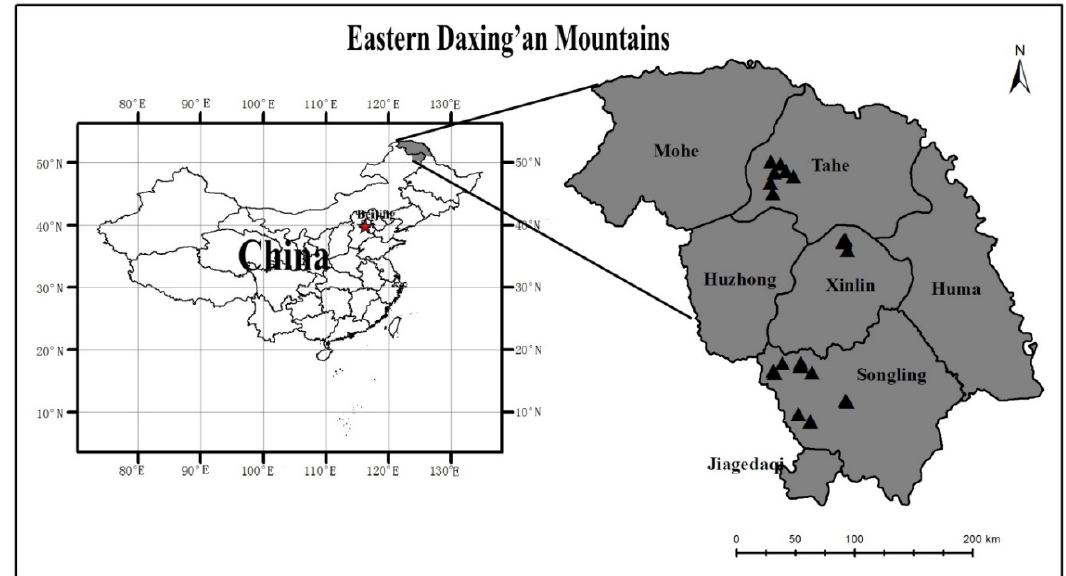
Figure 1. Geographical locations of the study area and sample plots in the eastern Daxing’an Mountains, northeast China.